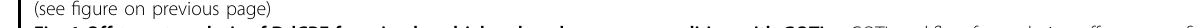
Fig. 1 Off-target analysis of DdCBE for mitochondrial and nuclear genome editing with GOTI. a GOTI work fl ow for analyzing off-target pro fi le of DdCBE. b The DdCBE target for generating the m.G12918A point mutation (D393N), m.C12336T nonsense mutation (Q199stop), and m.G12341A silent mutation (Q200Q) in the ND5 protein. Translation triplets are underlined and target sequences with possible editing loci are shown in red. c On-target ef fi ciency of ND5 -DdCBE (m.G12918A and m.C12336T) for tdTomato + and tdTomato – cells on the basis of WGS. Distribution pattern of off-target sites in m.G12918A ( d ) and m.C12336T ( e ) E14.5 fetuses (red dots) with Cre fetuses as control (blue dots). Spacer represents region between recognition sequences of the TALE pair. Each dotted box indicates a single off-target event. f Comparison of the total number of identi fi ed off-target SNVs in Cre and ND5 -DdCBE (m.G12918A and m.C12336T) injected groups by WGS. g Number of indels identi fi ed in Cre and ND5 -DdCBE (m.G12918A and m.C12336T) injected groups by WGS. h Proportion of C·G to T·A mutations among all identi fi ed SNVs for Cre and ND5 -DdCBE (m.G12918A and m. C12336T) injected groups. i Distribution of mutation types. The number in each cell indicates the proportion of a certain type of mutation among all mutations. j The distribution of off-target SNVs in the transcribed and untranscribed regions. k SNVs identi fi ed from all DdCBE-edited samples did not overlap, suggesting that off-targets on the nuclear genome were mainly caused by the sequence-independent activity of DdCBE. l Sequence logos generated from off-target sequences with C·G to T·A conversions by ND5 -DdCBE in nuclear genome. Bits re fl ect sequence conservation at a given position. Data are presented as the means ± SEM. P values were evaluated with the unpaired Student ’ s t -test